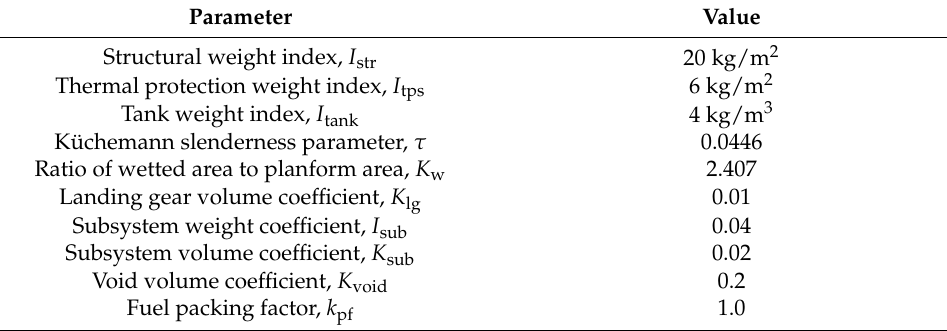
Table 1. Some technology parameters for the illustrative aircraft. Parameter Value Structural weight index, I str 20 kg/m 2 Thermal protection weight index, I